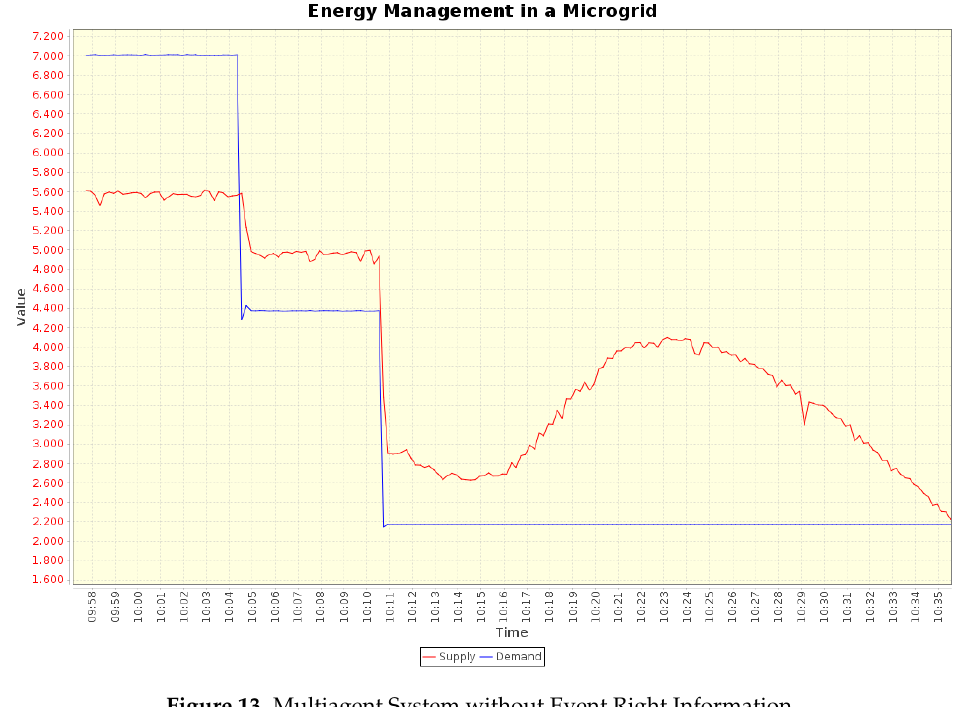
Figure 13. Multiagent System without Event Right Information.